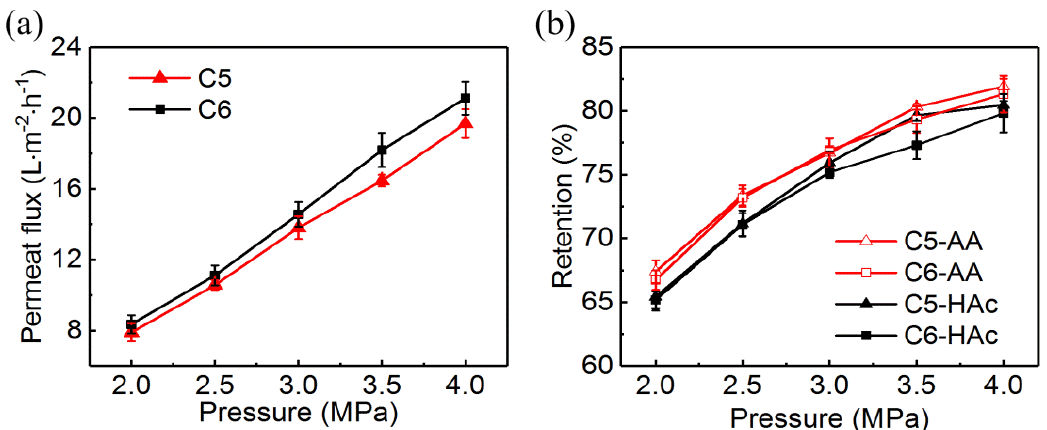
Figure 2. Effect of pressure on ( a ) permeate flux and ( b ) acrylic acid and acetic acid retentions. The concentrations of acrylic acid and acetic acid were 2.5%, 1.5%, respectively; temperature: 25 °C.